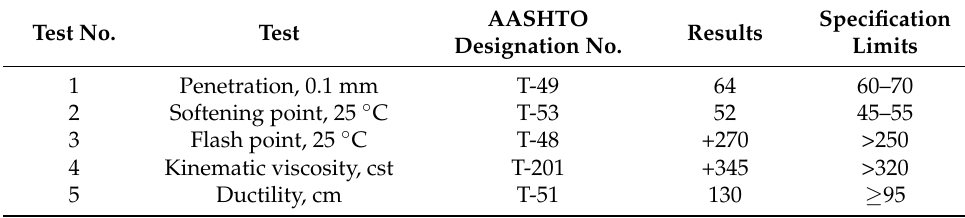
Table 3. Properties of used